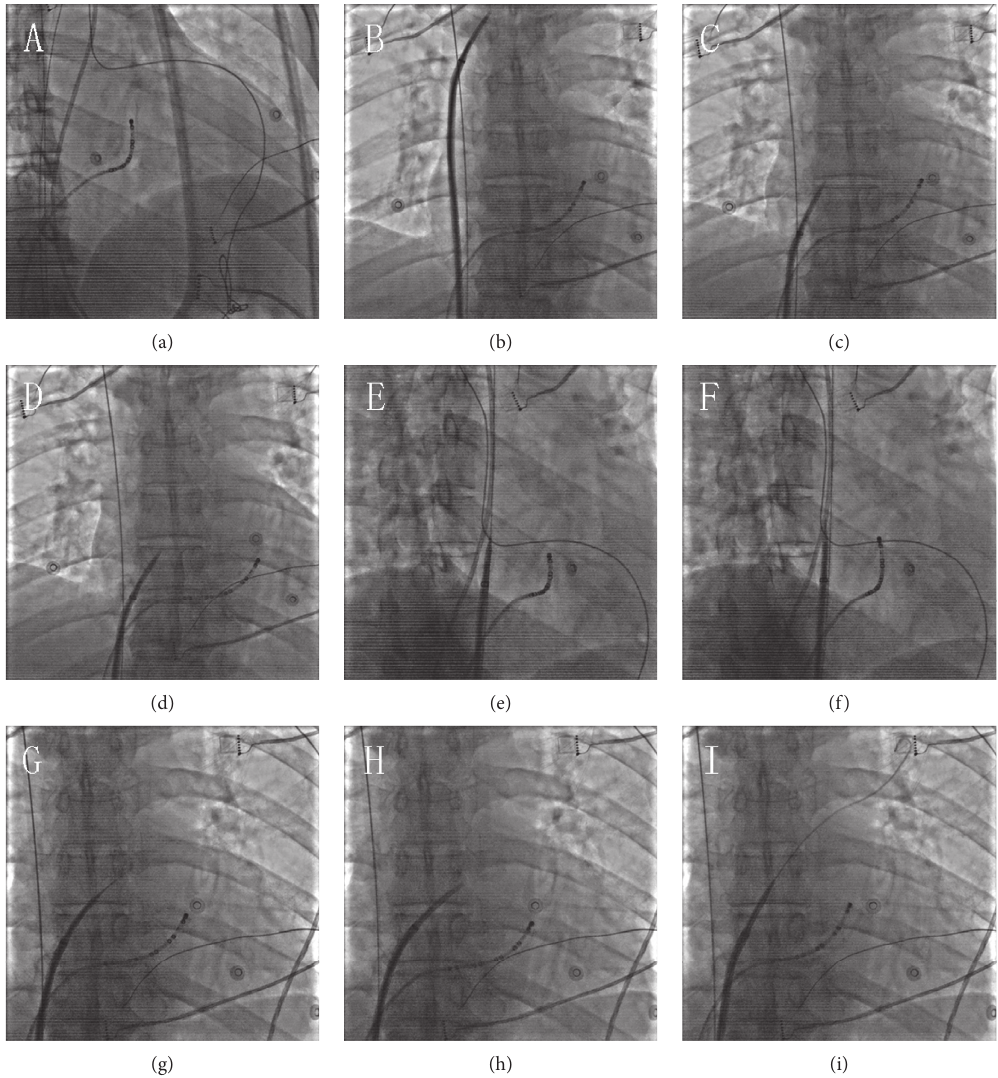
Figure 1: Transseptal puncture with fluoroscopy. (a) At the right anterior oblique (RAO) angle of 30 ° , a 10-polar diagnostic catheter was placed in the coronary sinus. (b) At the anterior posterior (AP) position, the long sheath was sent into the superior vena cava (SVC) through the guidewire. Then, we removed the guidewire and sent a transseptal needle into the long sheath. The distance between the tip of the long sheath and the tip of transseptal needle was about 1cm. (c, d) Upon withdrawal of the long sheath and the transseptal needle together, the tip of the sheath was observed to jump twice. After jumping for the second time, the tip was pointing toward to the foramen ovale. (e) RAO 45 ° was used to confirm that the tip of the sheath was vertical to the atrial septum. (f) A transseptal needle was used to puncture the atrial septum. (g) Contrast medium was injected into LA through the needle, and a dark thick line was shown under fluoroscopy at the AP position. (h, i) We pushed dilator inside the long sheath through the transseptal needle into the LA. Then, the needle was withdrawn, and the long wire was placed in the left superior pulmonary